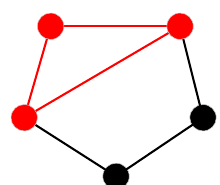
Figure 5. Motif of M 2 in a simple